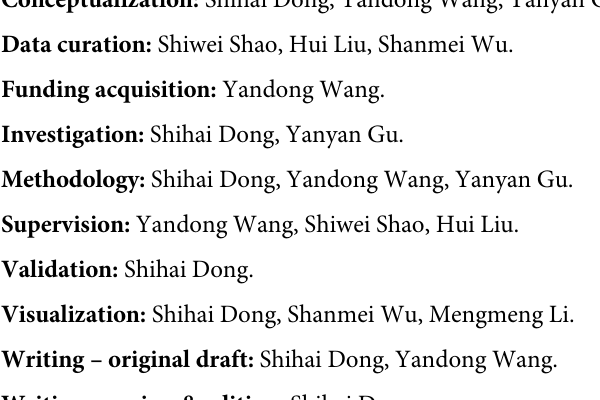
S3 Table. Data of housing prices in Qiaokou district for case 2. S4 Table. Data of housing prices in Qingshan district for case